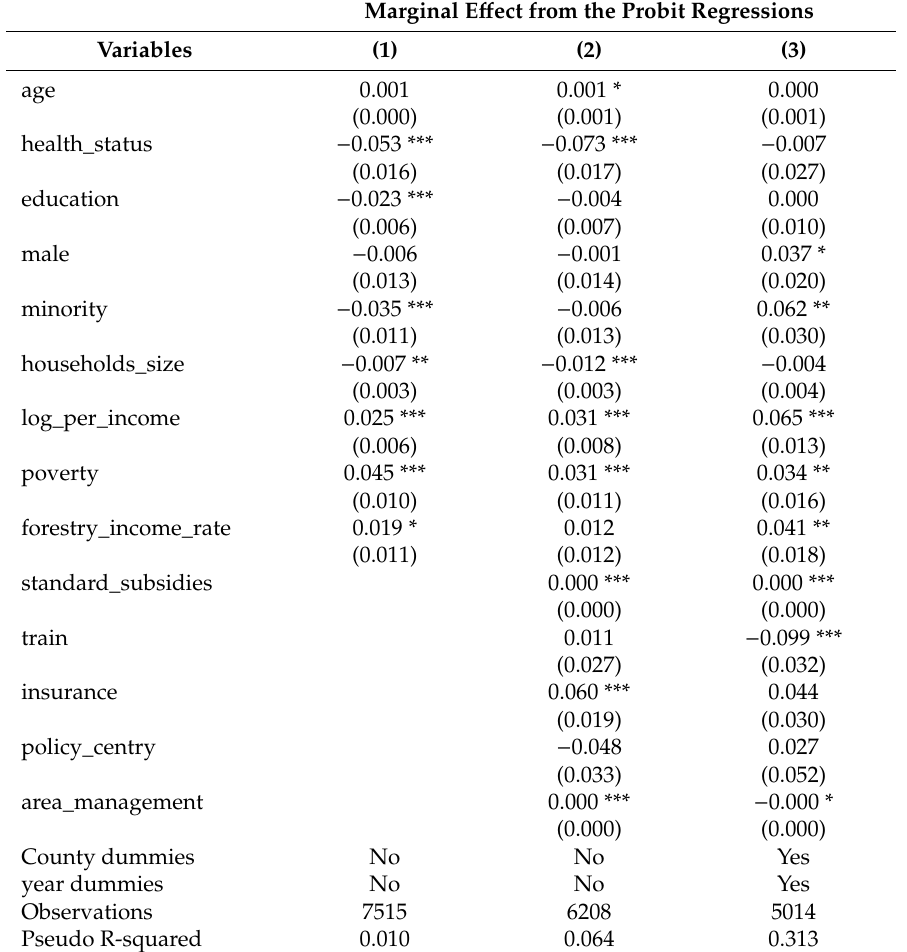
Table 9. The influencing factors of the re-employment behavior of ecological forest rangers